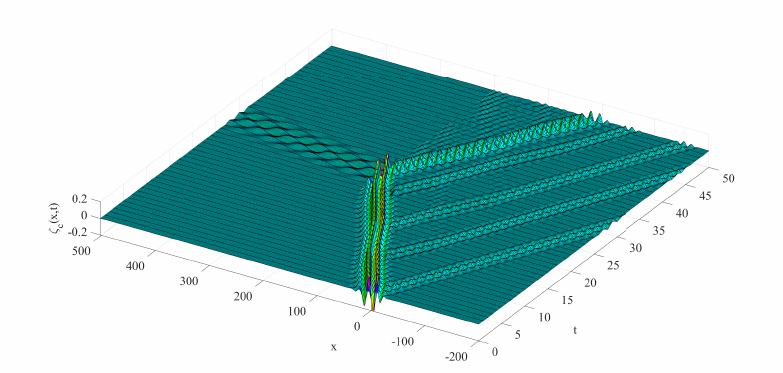
Figure 18. Variation of the free surface displacement ζ c ( x , t ) (m) versus x (m) and time t (s) in the case of a semi-infinite plate in the presence of double